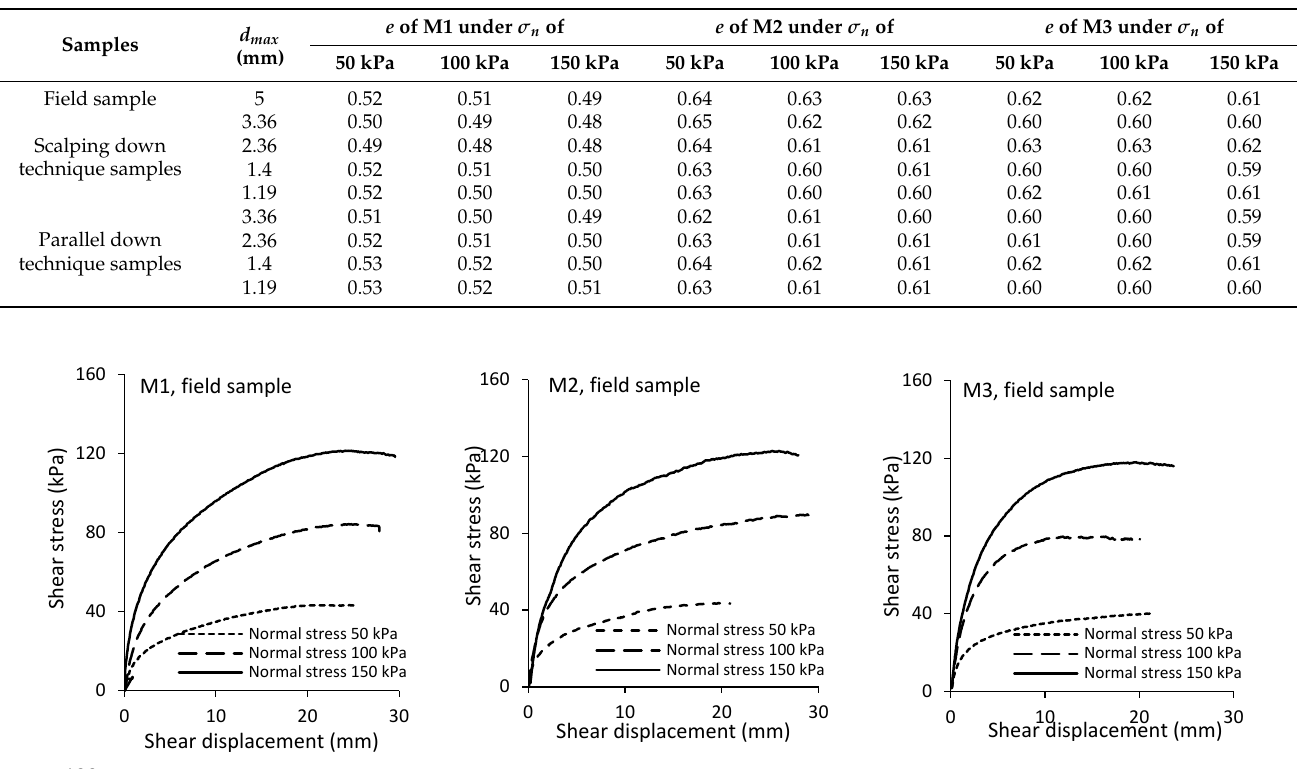
Table 4. Void ratio ( e ) of the tested specimens after the application of normal stresses ( σ n ) before applying shear strains.